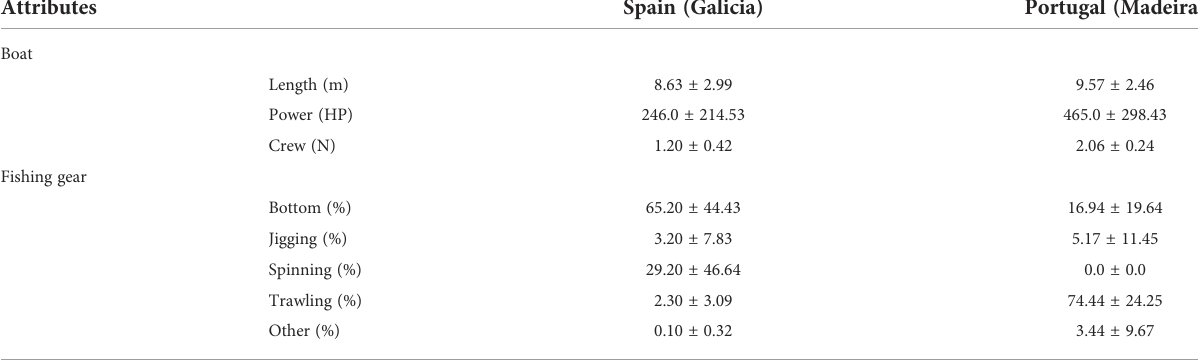
TABLE 1 Mean (and SD) characteristics of recreational fi shing charter boats and percentage of annual fi shing time using each gear in Spain (Galicia) and Portugal (Madeira archipelago). Attributes Spain (Galicia) Portugal